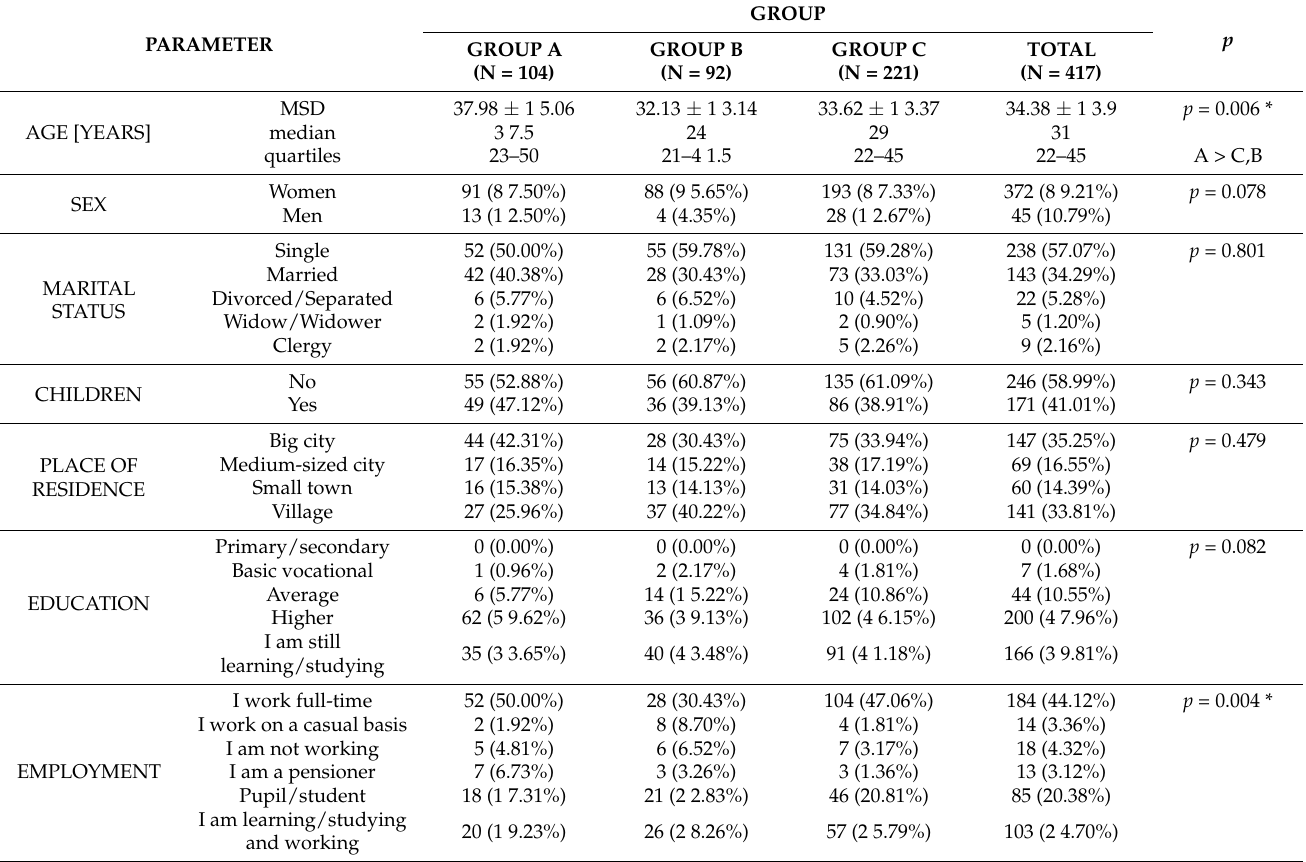
Table 2. Differences between groups on sociodemographic variables.